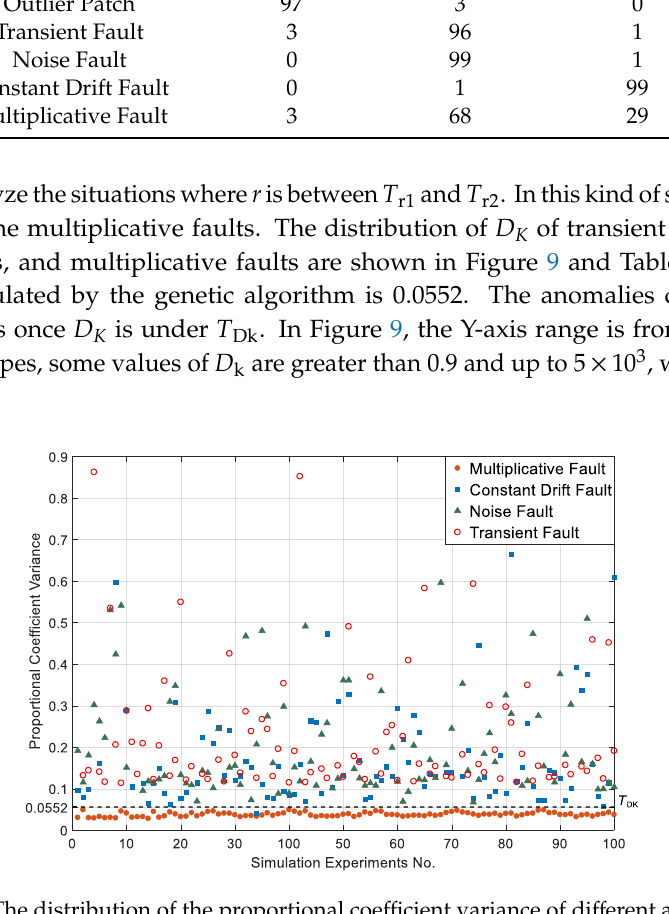
Figure 9. The distribution of the proportional coefficient variance of different anomalies.